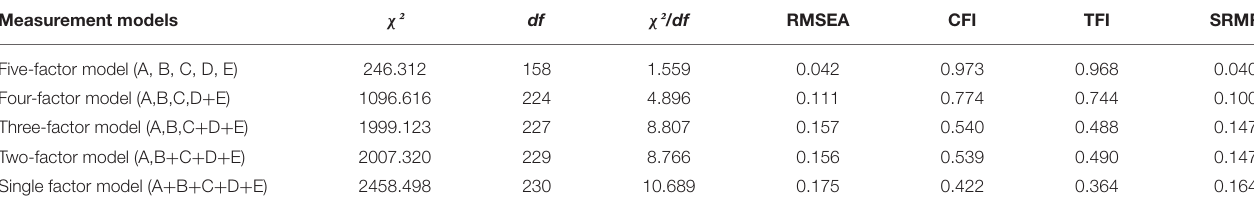
TABLE 1 | Results of confirmatory factor analysis of the measurement models. Measurement models χ ² df χ ² /df Five-factor model (A, B, C, D, E)